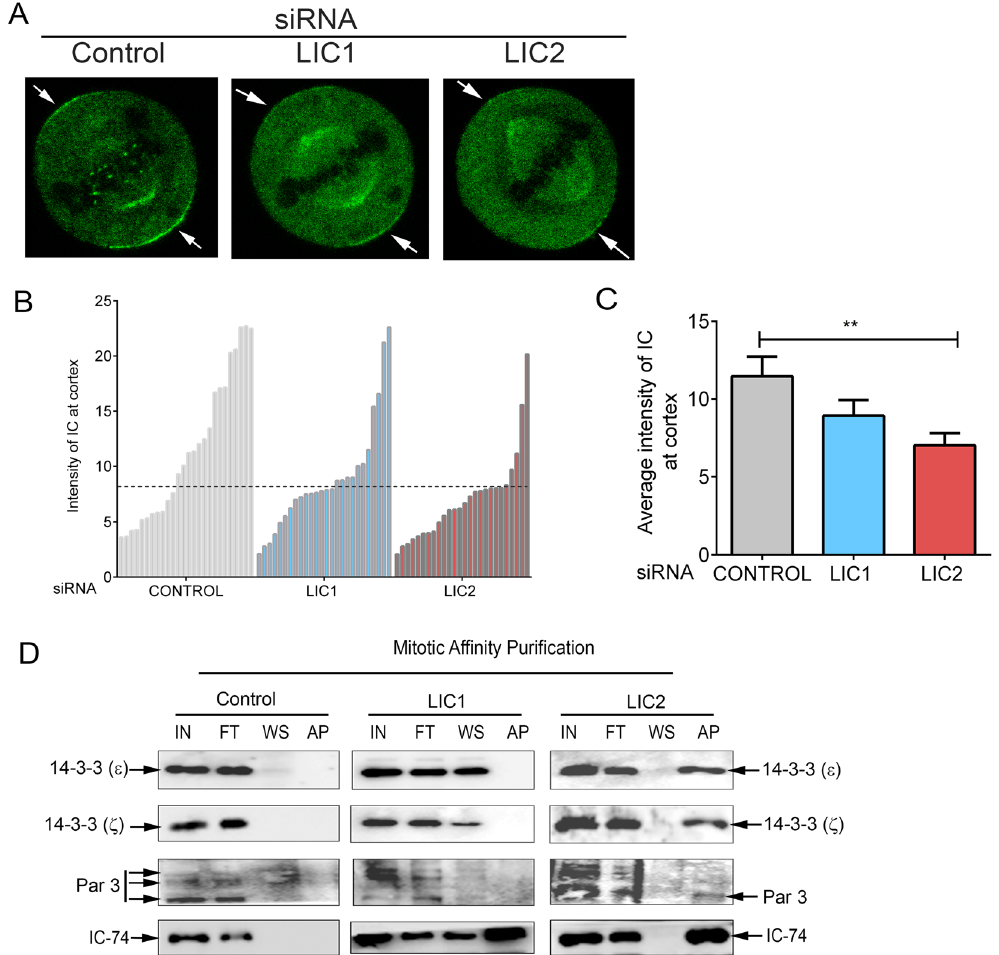
Figure 5. LIC2-dynein interacts with cortical orientation complexes. ( A ) Still images from time-lapse movies of HeLa cell line expressing multifunctional GFP-tagged IC74 (mfGFP-IC74). Arrows indicate cortical dynein. ( B ) Quantification of cortical intensity of mfGFP-IC74 upon respective siRNA treatments. Y-axis represents average fluorescence intensity at the cortex, each bar represents one cell. Horizontal dashed line marks the average fluorescence intensity seen in LIC2-depleted cells. N = 26 cells each for all conditions. LIC2-depleted cells show significantly reduced mfGFP-IC74 cortical intensity in comparison to control or LIC1-depleted cells. ( C ) Quantification of mfGFP-IC74 intensity at the cortex upon respective siRNA treatment. Bars represent mean + / − SEM from 3 independent experiments. N = 26 live metaphase cells from 3 independent experiments). ( D ) Affinity purification of SBP-tagged empty vector (control), LIC1 and LIC2 followed by immunoblotting with respective antibodies as indicated. IN = input, FT = flow through, WS = wash, AP = affinity purified